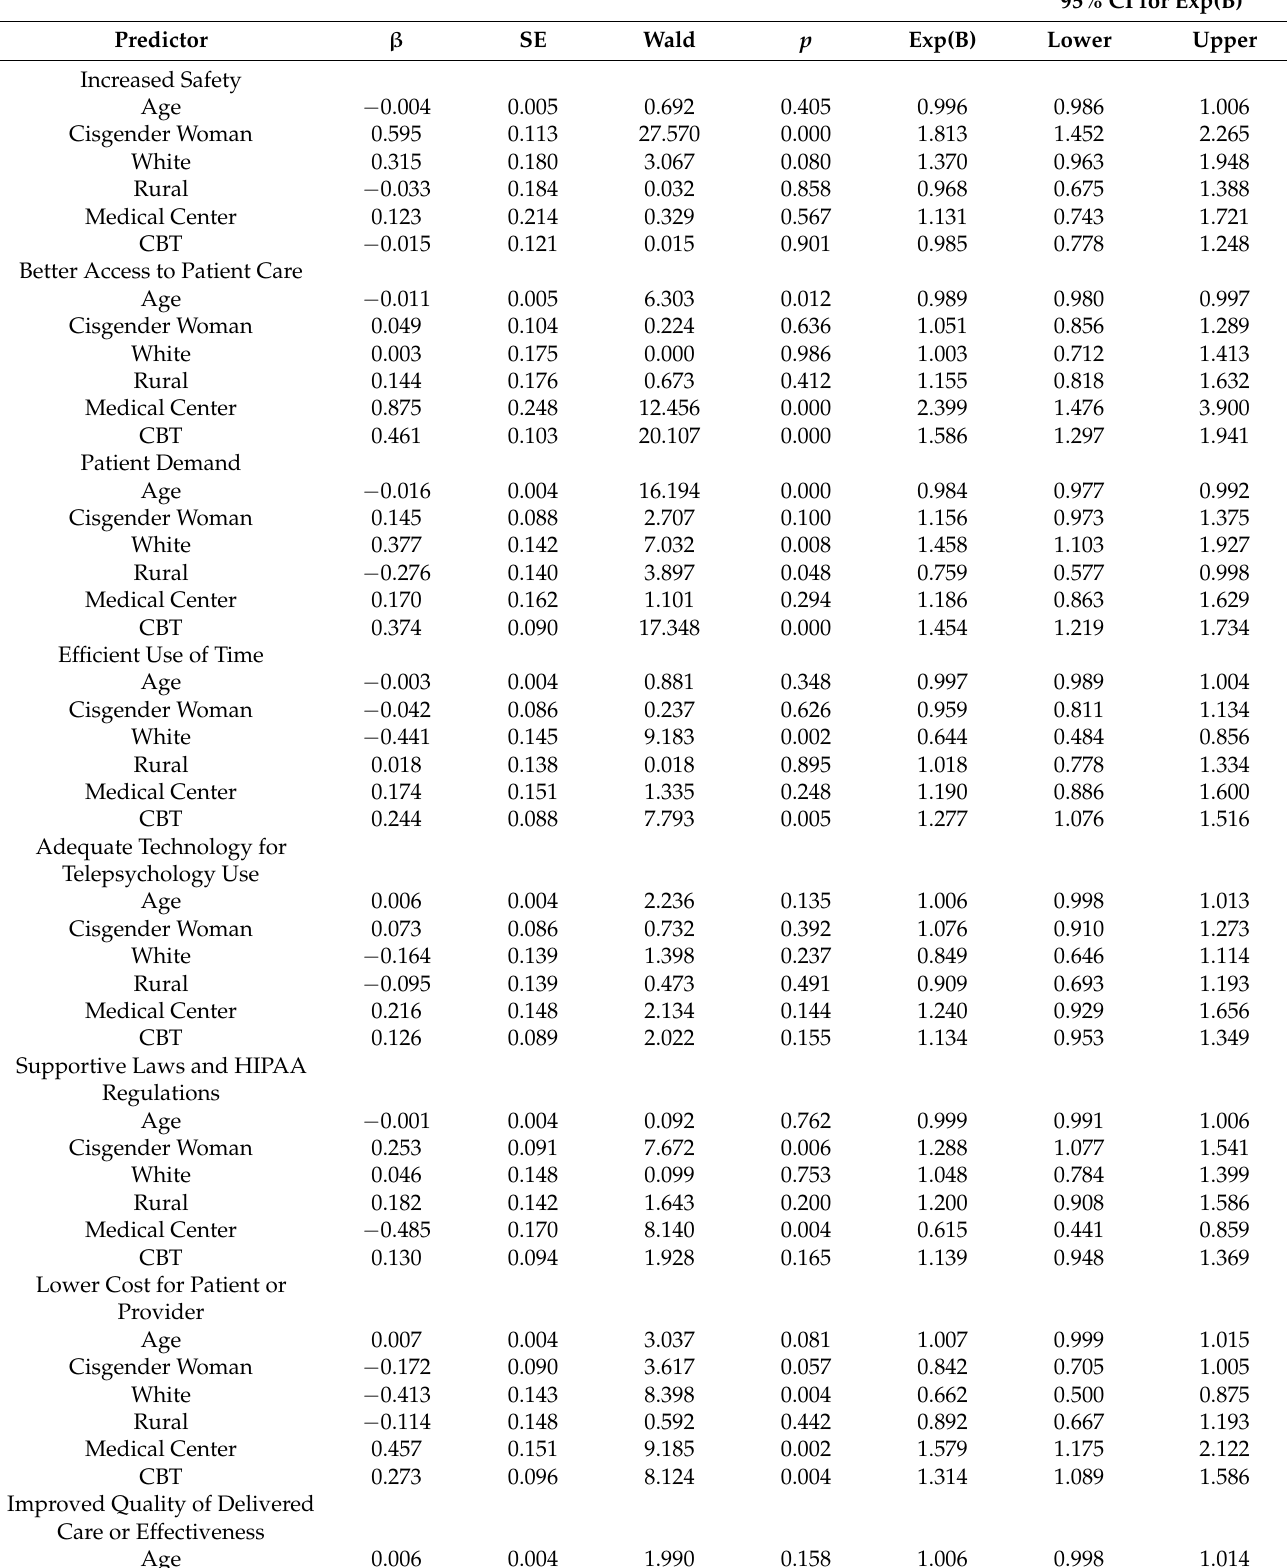
Table 5. Variables in the Logistic Regressions for